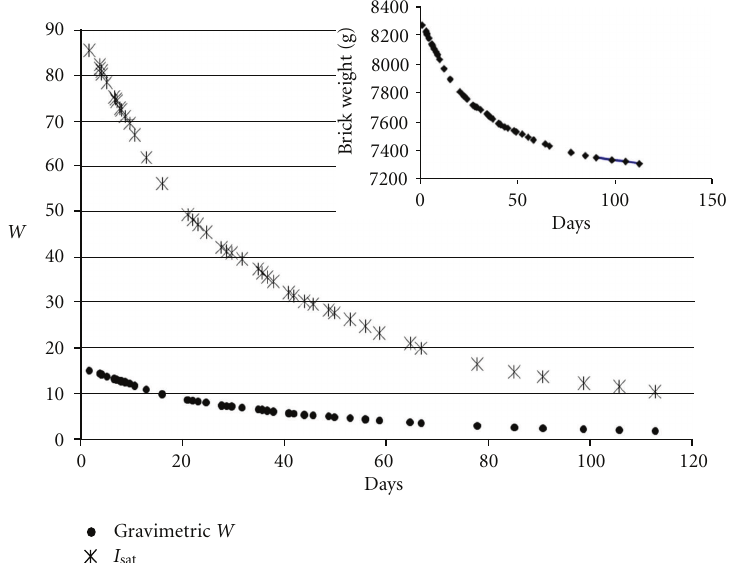
Figure 7: Evolution of weight, gravimetric water content ( W ), and saturation index ( I sat ) of the earth brick during the 110 days of desiccation.